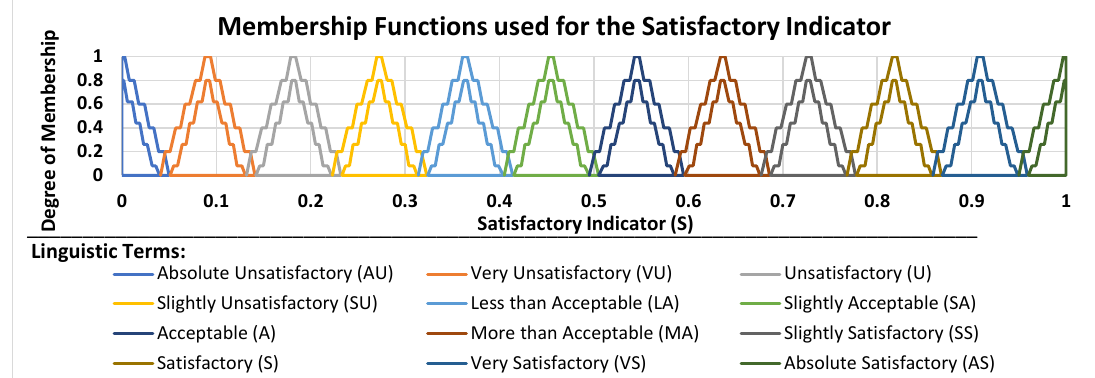
Figure 6. The membership functions used for the representation of the Satisfactory